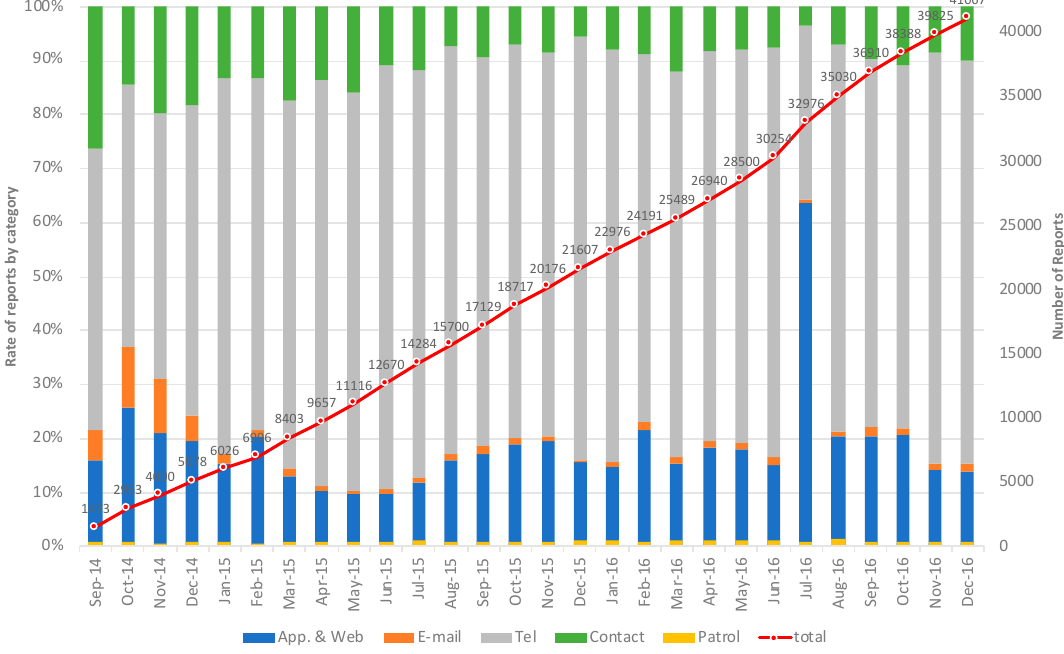
Figure 7. Shifts in Chiba-repo reporting methods over time.